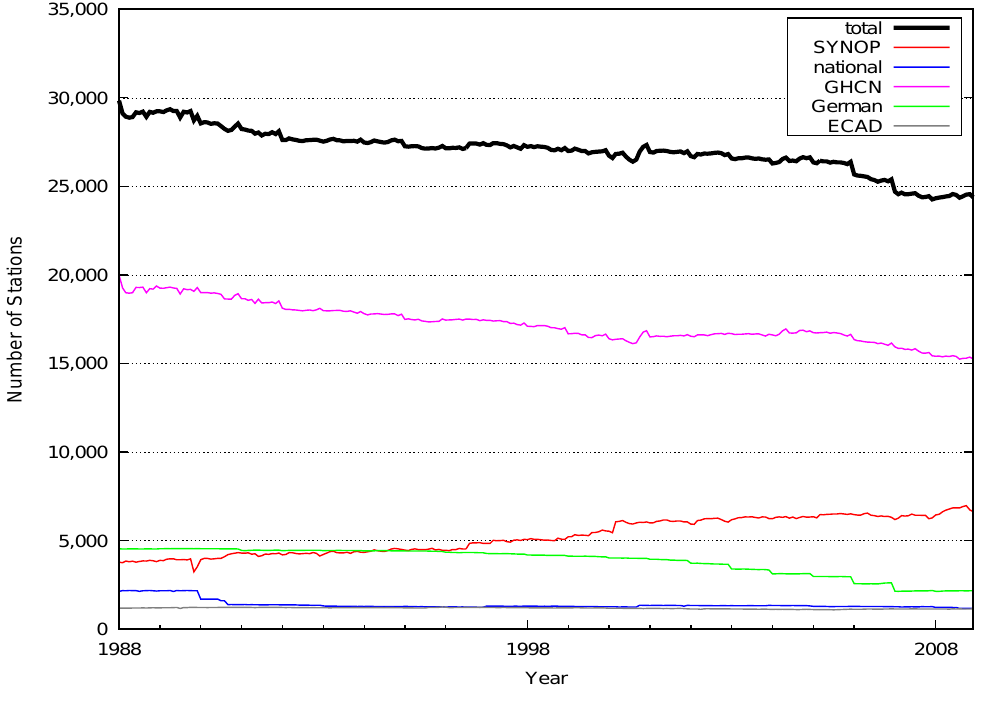
Figure 1. Temporal distribution of used land-surface stations. “SYNOP” are stations distributed via the World Meteorological Organisation Global Telecommunication System (WMO-GTS) , “National” are data provided by national meteorological and/or hydrological services, “GHCN” are data from the Global Historical Climatology Network [11], “German” are stations operated by Deutscher Wetterdienst (DWD) , “ECAD” are data from the European Climate Data and Assessment [12], and “Total” is the set union of all available stations at one date (multiple stations counted only